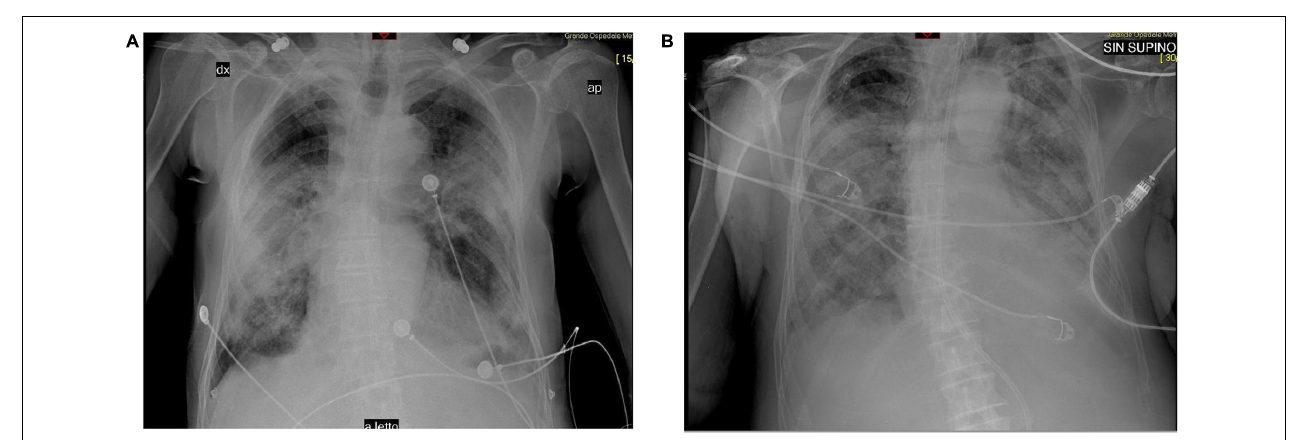
Frontiers in Immunology |